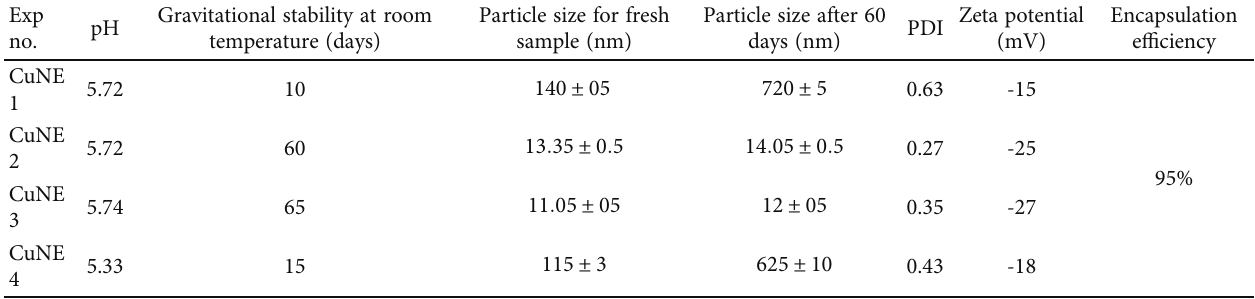
Table 2: pH and gravitational stability of nanoemulsion